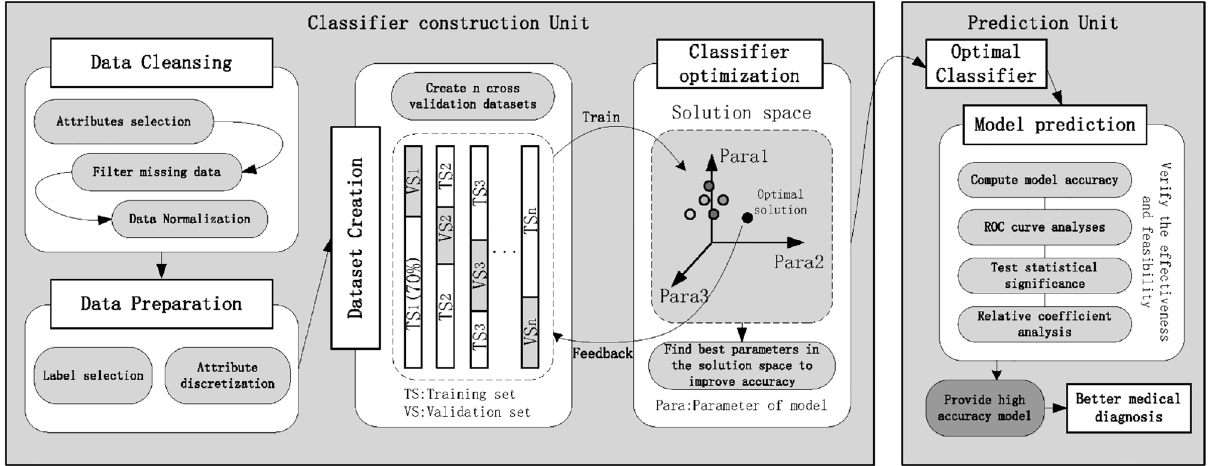
Figure 1. Diagram of fundamental steps in machine learning-based medical diagnosis